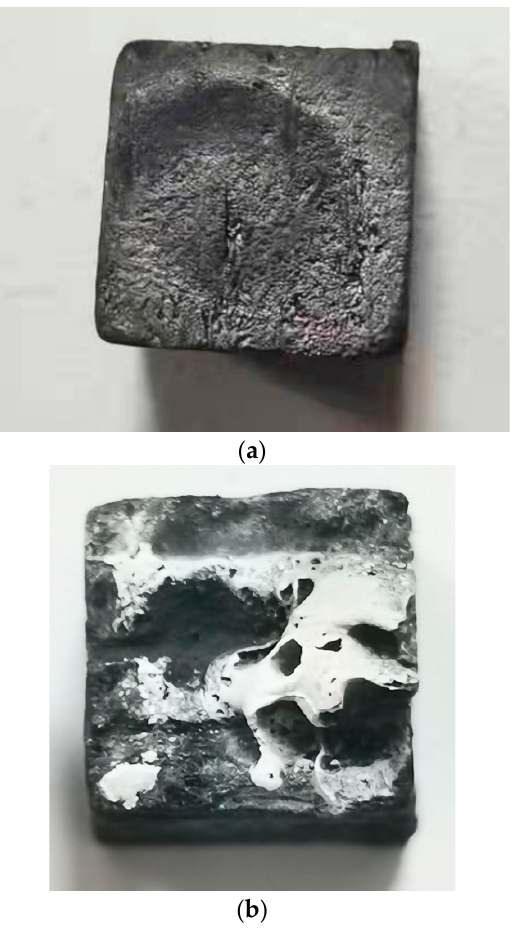
Figure 11. Macroscopic morphology of C/C composite matrix and laser cladding coating after ablation. ( a ) C/C composite matrix; ( b ) laser cladding coating.